Question: Which kind of chart has been used to present this data?
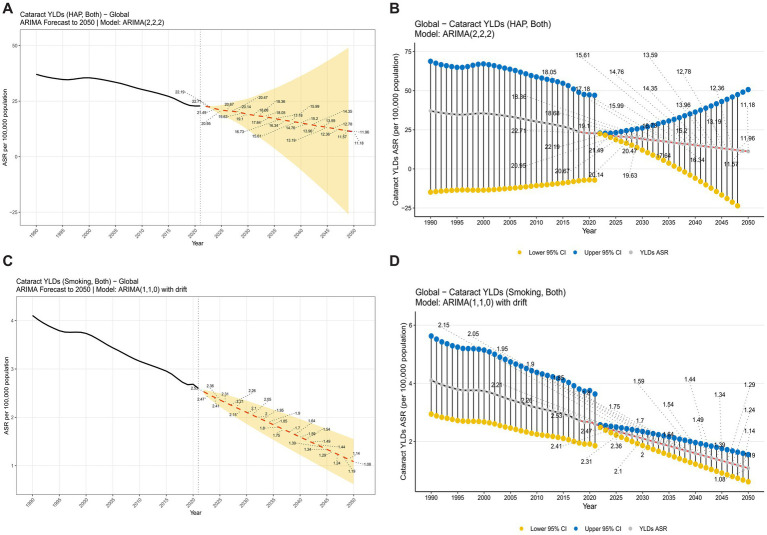
Answer: line